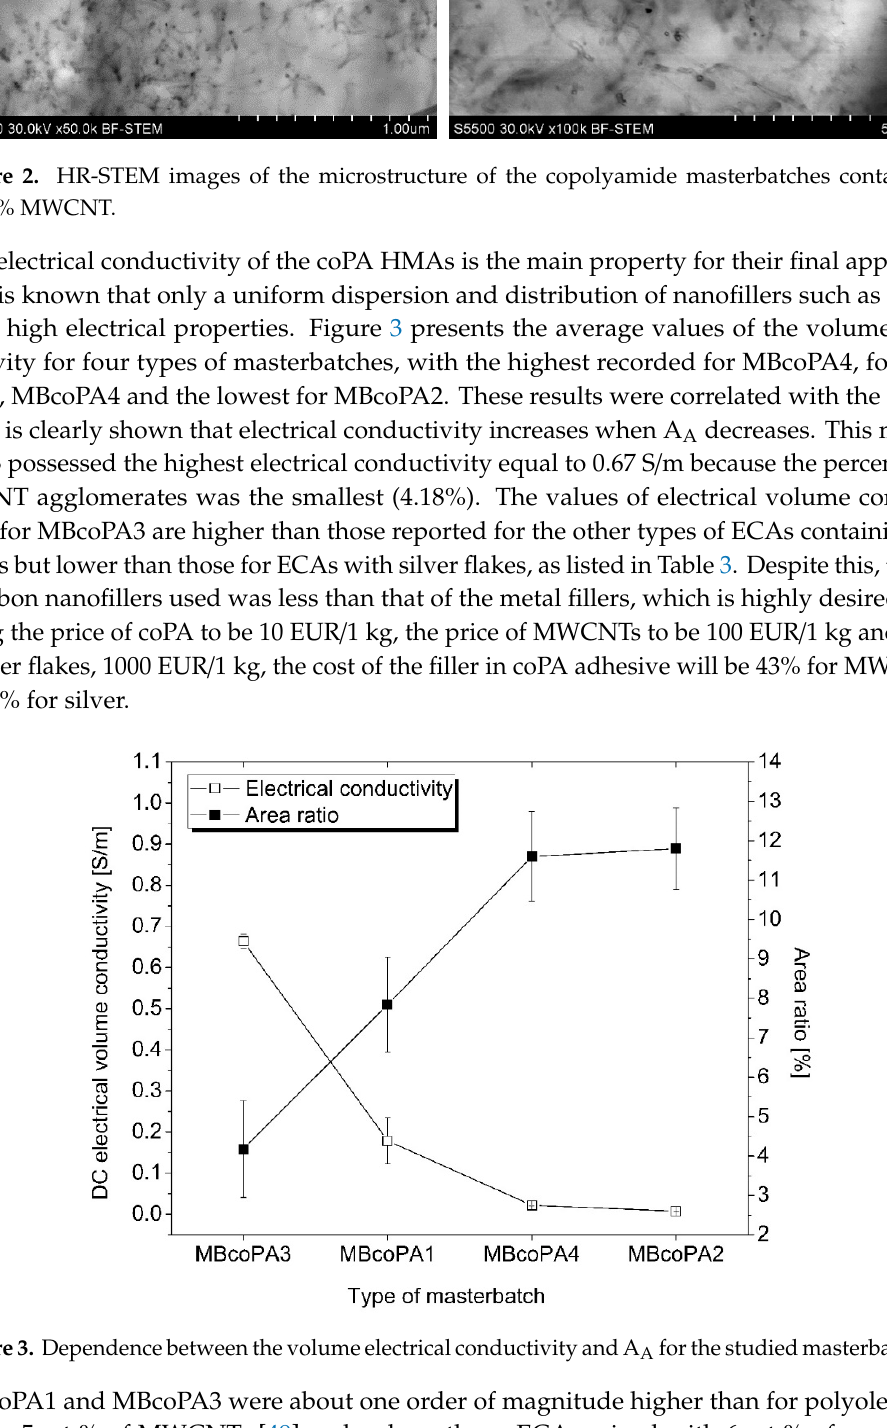
Figure 3. Dependence between the volume electrical conductivity and A A for the studied masterbatches.